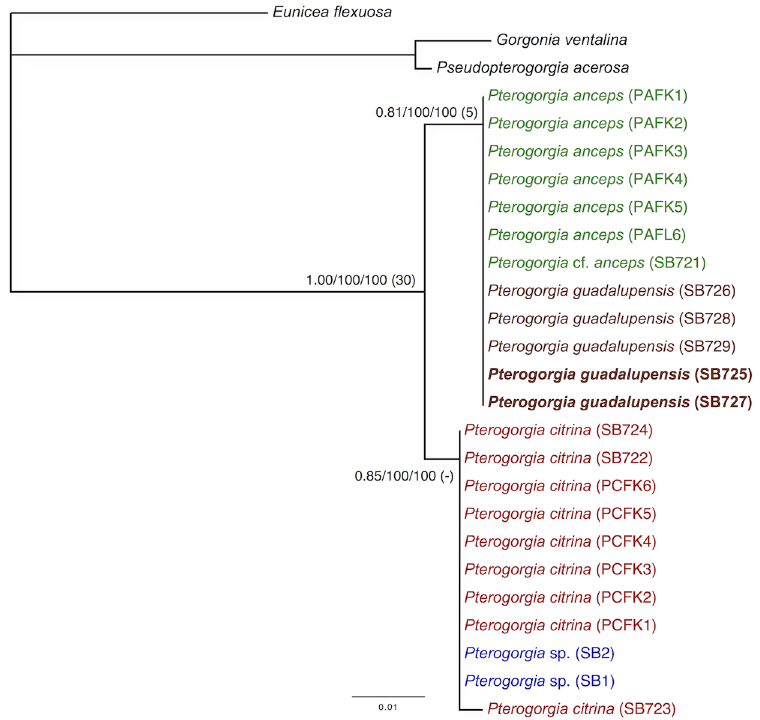
Fig 4. Mitochondrial phylogeny. Phylogram generated by a concatenated mitochondrial data set ( mtMutS + cytb + igr 4) using Bayesian Inference (BI), maximum likelihood (ML), and maximum parsimony (MP). Node support for BI, ML and MP is shown from left to right, with Bremer decay values in parentheses. Taxa in bold are individuals whose placement differed between the mitochondrial and SRP54 (nuclear) phylogenies (see Fig